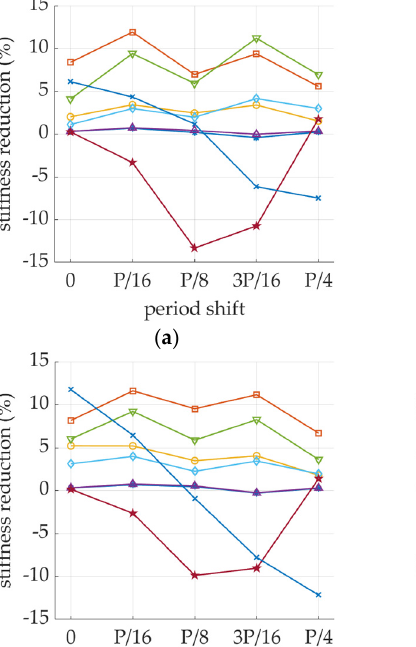
Figure 14. Stiffness degradation in a sample DW: ( a ) F-15; ( b ) F-30; ( c ) F-45; ( d ) F-60; ( e ) F-75. Three types of perforation were analyzed (2/6 mm, 4/4 mm, or 6/2 mm).